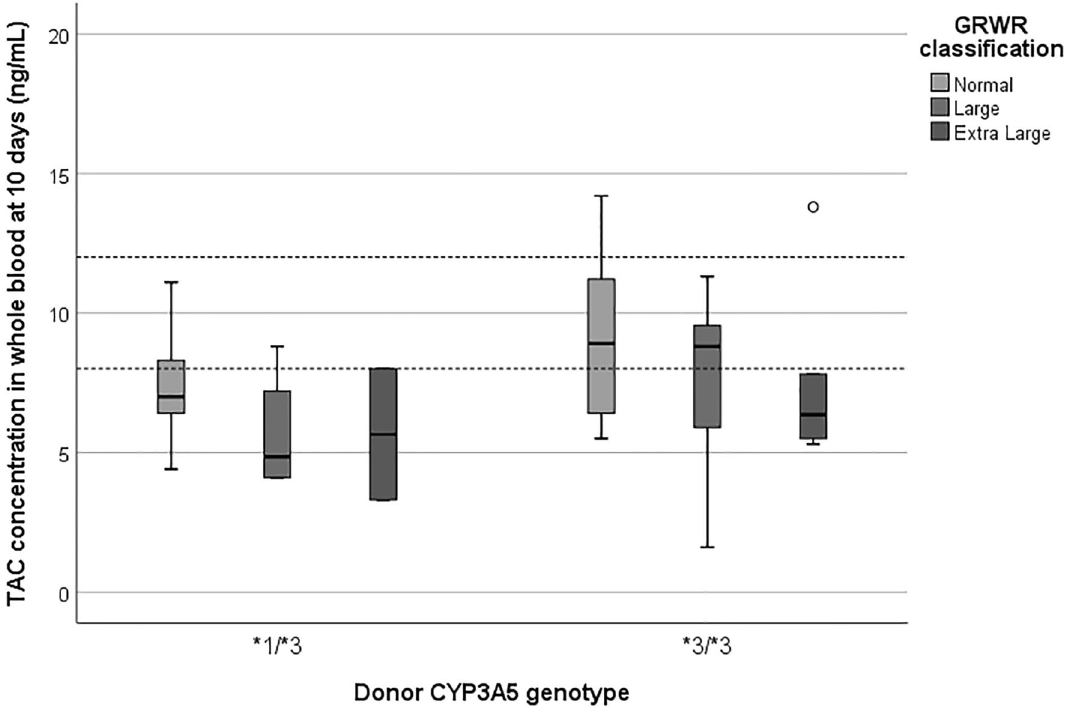
Figure 2. TAC blood concentrations on the 10th post-transplant day stratified by GRWR and the donor CYP3A5 genotype. TAC, tacrolimus; GRWR, Graft-to-Recipient Weight